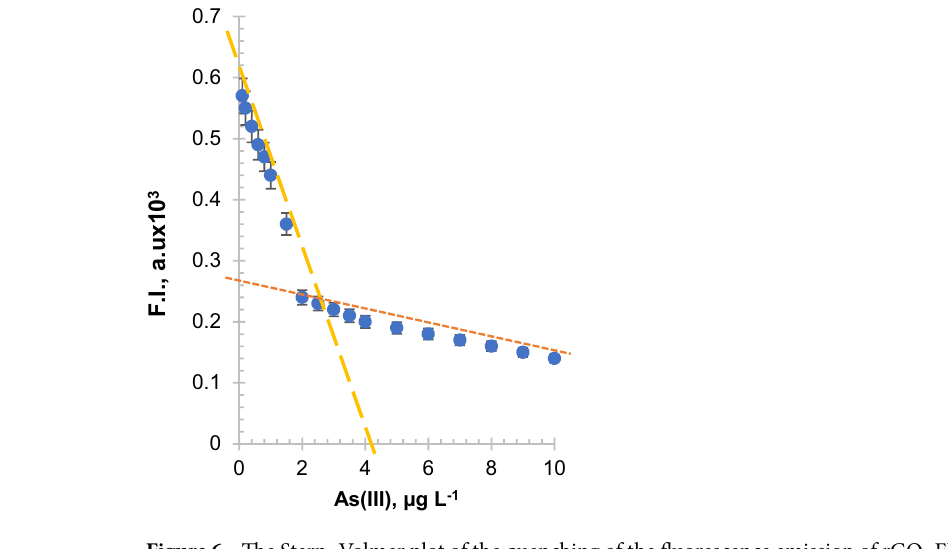
Figure 6. The Stern–Volmer plot of the quenching of the fluorescence emission of rGO–FL nanoparticles during adsorption of As(III) in aqueous